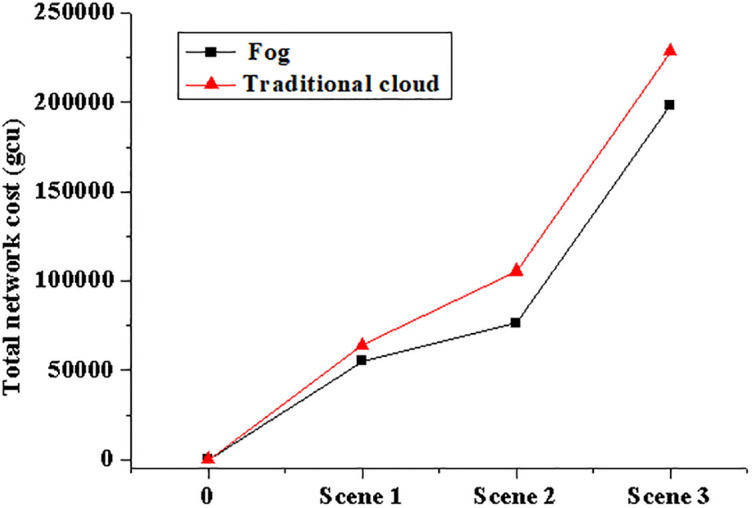
Comparative analysis of network costs of different schemes under each scenario.